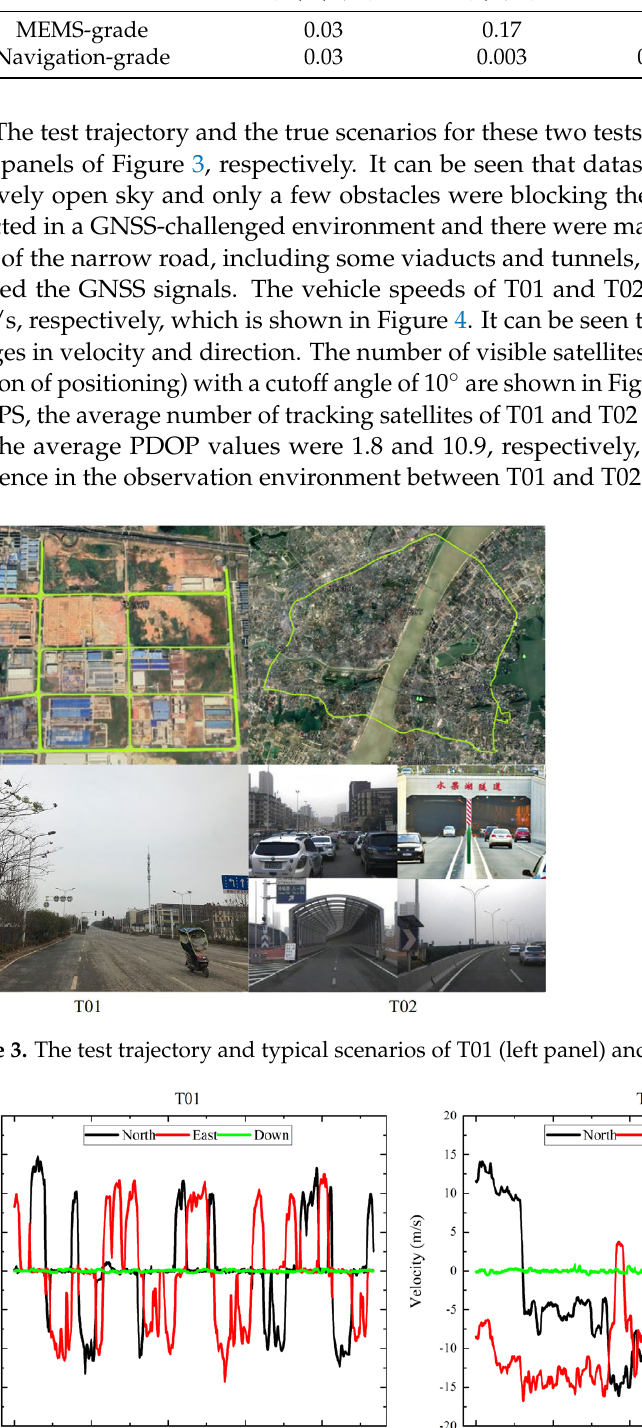
Figure 4. Velocity of the vehicle for T01 (left panel) and T02 (right panel), respectively.